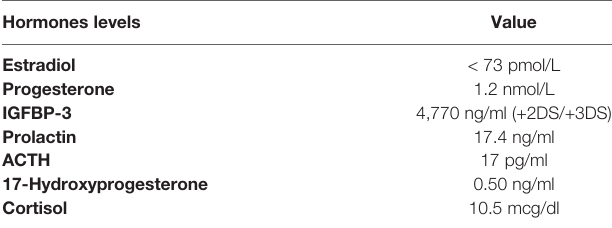
TABLE 2 | Pituitary hormones levels performed at diagnosis of duplication of the pituitary gland (DPG)-plus syndrome in a 5-year-old female. Hormones levels Value